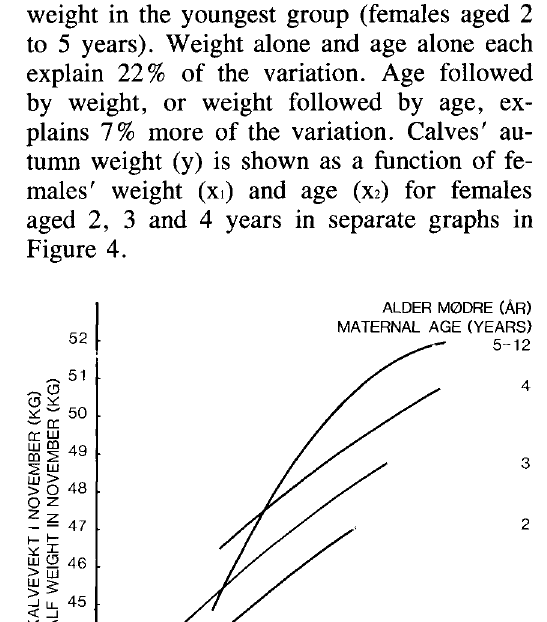
Figure 4. Relationship between reindeer calves' weight in autumn (y) and their dams' weight (xi )in spring and age (xz). Figur 4. Sammenhengen mellom reinkalvenes høstvekt (y) og mødrenes vårvekt (xi) samt alder